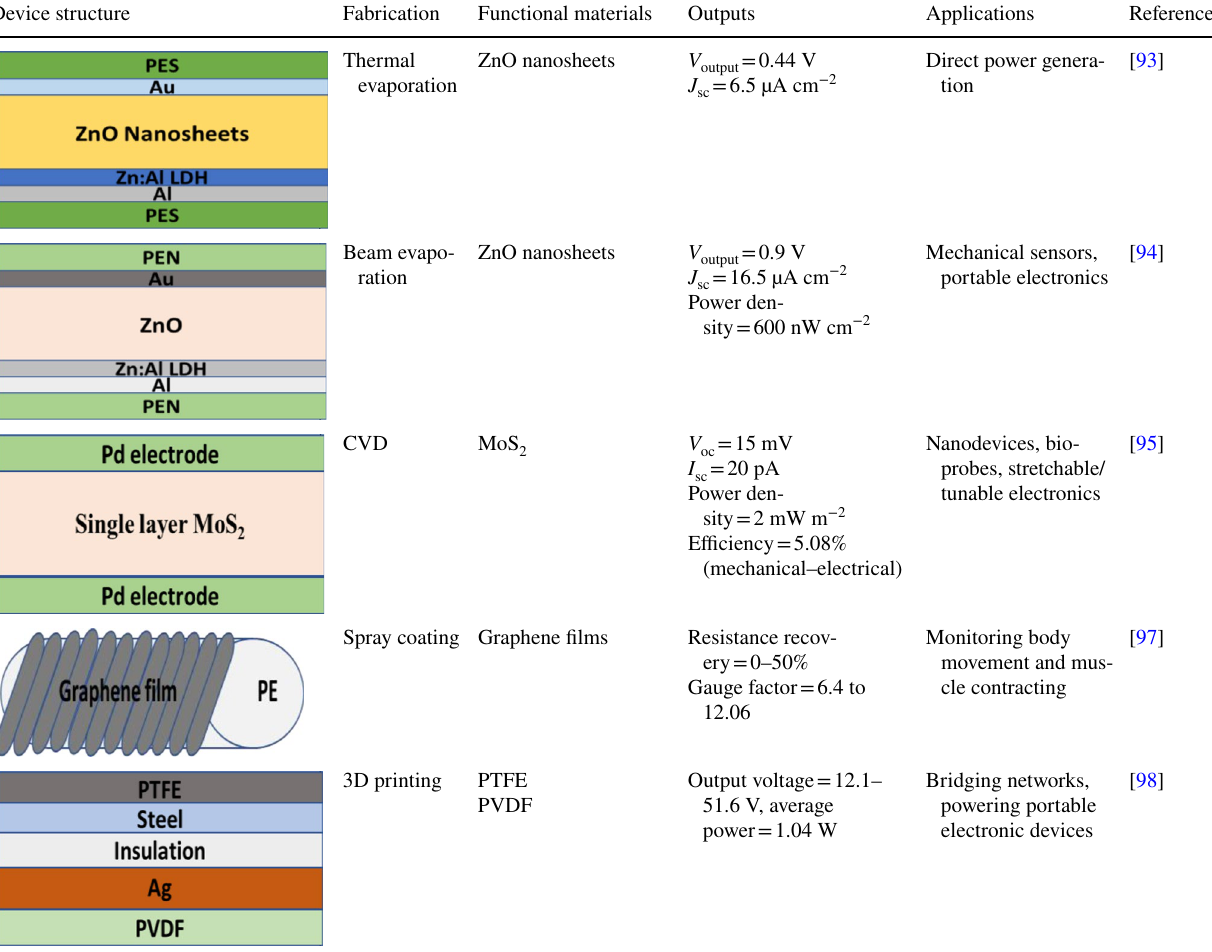
Table 3 Comparative summary of reported work on piezoelectric energy harvesting including device structure, functional materials, fabrication techniques, device outputs, and applications Device